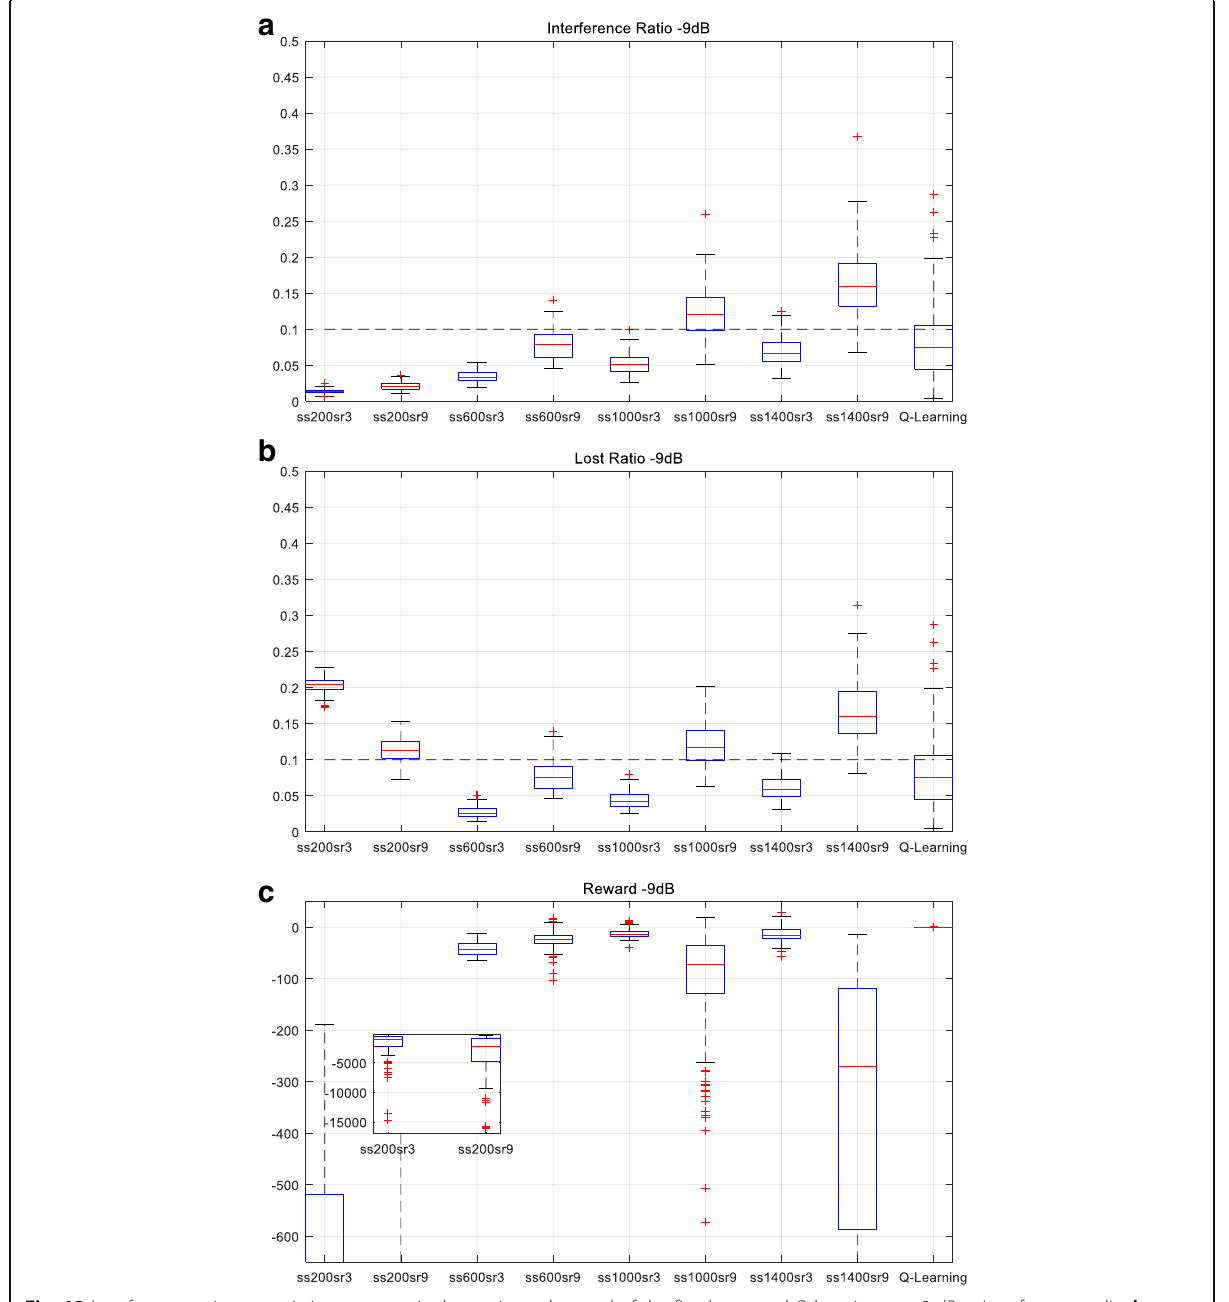
Fig. 13 Interference ratio, transmission opportunity loss ratio, and reward of the fixed case and Q-learning @ − 9 dB. a Interference radio. b Transmission opportunity loss ratio. c Reward. The performance of the interference ratio, transmission opportunity loss ratio, and reward is compared for cases where the sensing time and the reply time are fixed and the proposed Q-learning is used for SNR of − 9 dB. In a representing the interference ratio and b representing the transmission loss ratio, the Q-learning operates within a stable range. For the case where the sensing time and the reapply time are fixed, the transmission opportunity loss ratio increases for ss200sr3 and ss200sr9, and the intereference ratio and transmission opportunity loss ratio for ss100sr9 and ss1400sr9 increase. In c indicating a reward, the Q-learning shows overwhelming performance difference compared to other cases. Thus, it can be shown that the system load can be reduced by using